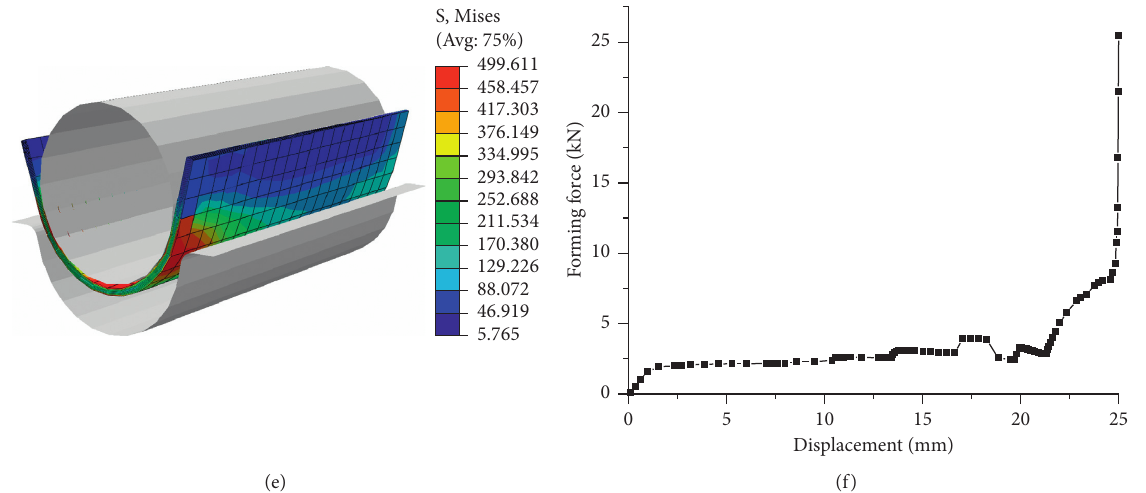
Figure 12: Deformation characteristics of cylindrical bending TRB: punch displacement (a) at h � 0.349mm, (b) at h � 3.86 mm, (c) at h � 19.93mm, (d) at h � 23.79mm, and (e) after unloading; (f) displacement-forming force